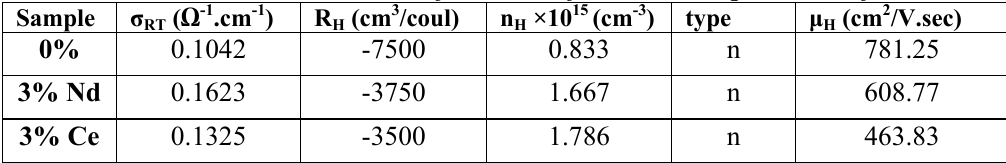
Table 3: Hall measurements results of V